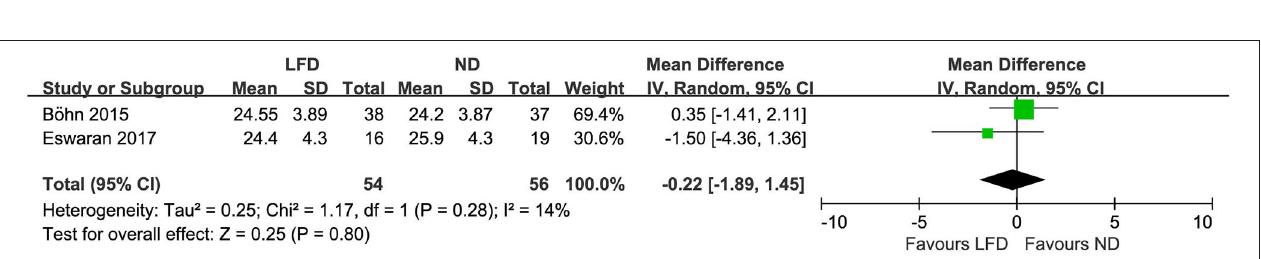
Frontiers in Nutrition | www.frontiersin.org 9 August 2021 | Volume 8 | Article